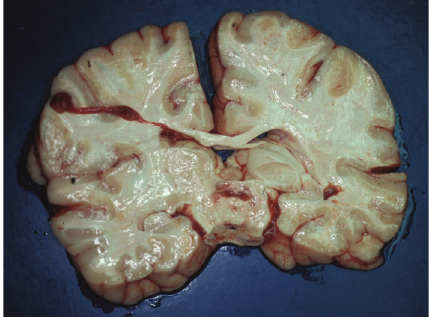
Figure 3: Histological picture of the macroscopic lesion of the pons (HE,